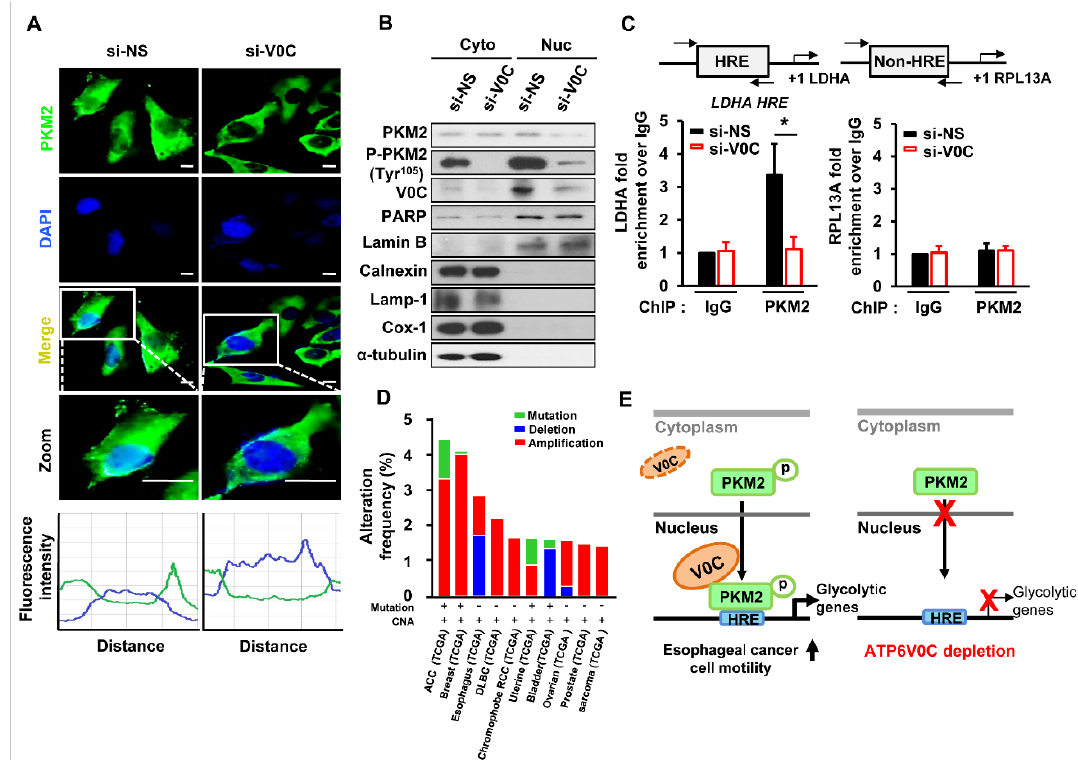
Figure 5. ATP6V0C increases expression of glycolytic genes by inducing nuclear translocation of PKM2. ( A ) TE8 cells were immunostained with PKM2 antibody (PKM2, green). The nucleus is marked with DAPI (blue). Merged images (Merge) are shown. Fluorescenceintensity was shown in linear histogram. The intensity was divided into two groups: PKM2 fluorescence intensity is plotted on the green peak, and DAPI intensity is plotted on the blue peak. The line profiles were placed across cells, and the simultaneously occurring intensity peaks were evaluated. The line profiles of PKM2 and DAPI signals were measured by ZEN 2011 software (Carl Zeiss). Scale bars = 10 µ m. ( B ) Nuclear and cytosolic lysates were prepared from ATP6V0C-depleted TE8 cells, followed by immunoblotting. ( C ) Recruitment of PKM2 by ATP6V0C at the HRE site of the indicated promoter. TE8 cells were transfected with NS or si-V0C and subjected to ChIP assays. Each data point is the average of three independent measurements. Values are mean ± SEM. (Student’s t -test; * p < 0.05). ( D ) Frequency of copy number alterations and mutations of ATP6V0C across several tumor types. ( E ) Proposed model of how ATP6V0C mediates metabolic programming in ECCs. ATP6V0C associates with PKM2 to enhance its nuclear localization and increases PKM2 phosphorylation, inducing transcriptional expression of glycolytic genes and thus facilitating glycolysis and motility in ECCs.